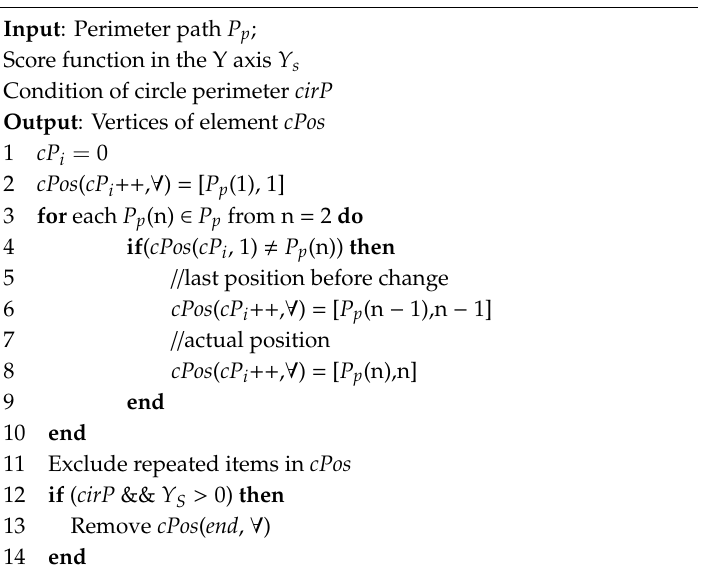
Algorithm 2. Element Vertices